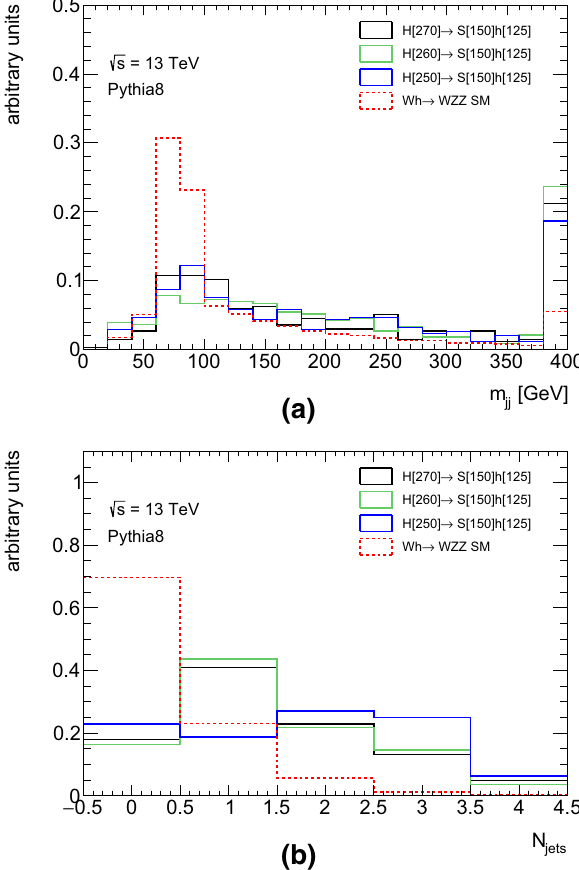
Fig. 10 Dijet invariant mass ( a ) and jet multiplicity ( b ) for several H → Sh samples (solid lines) compared with the SM Wh process with h → Z Z → 4 (cid:4) and W → q ¯ q (dashed line) generated with PYTHIA8 . The last bin contains overflow